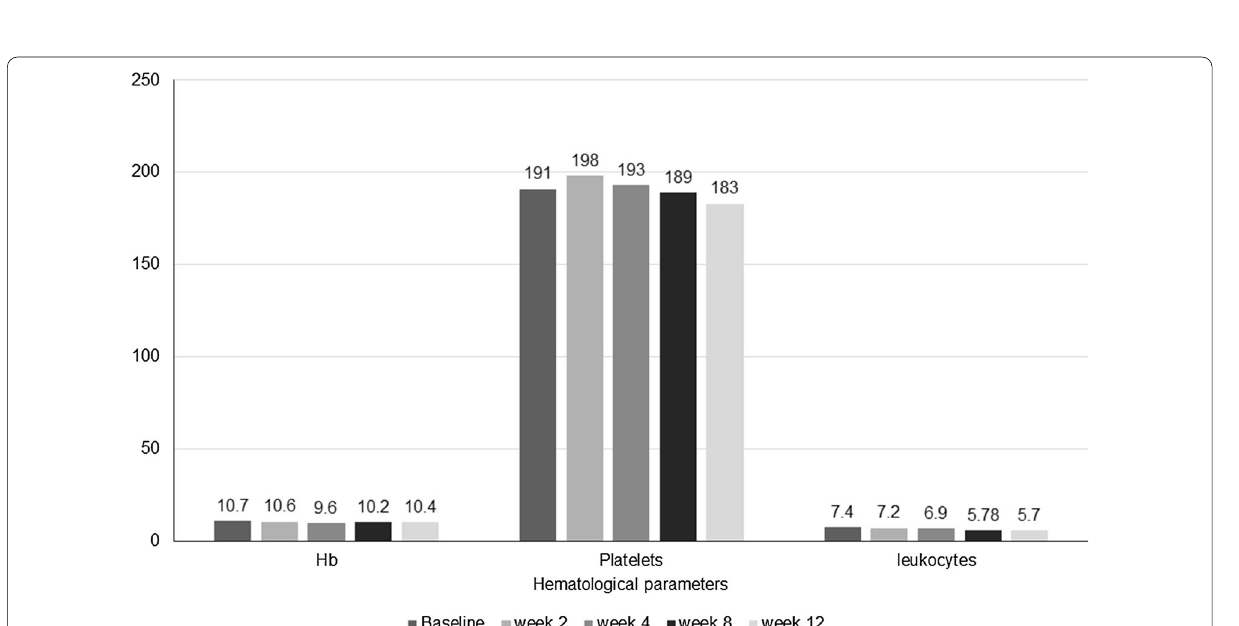
ALP alkaline phosphatase, IQR interquartile range